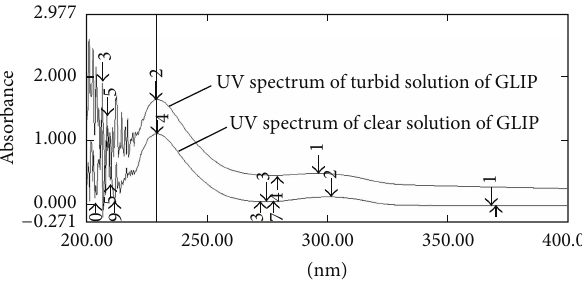
Figure 1: Overlain UV spectra of clear and turbid solutions of glipizide.